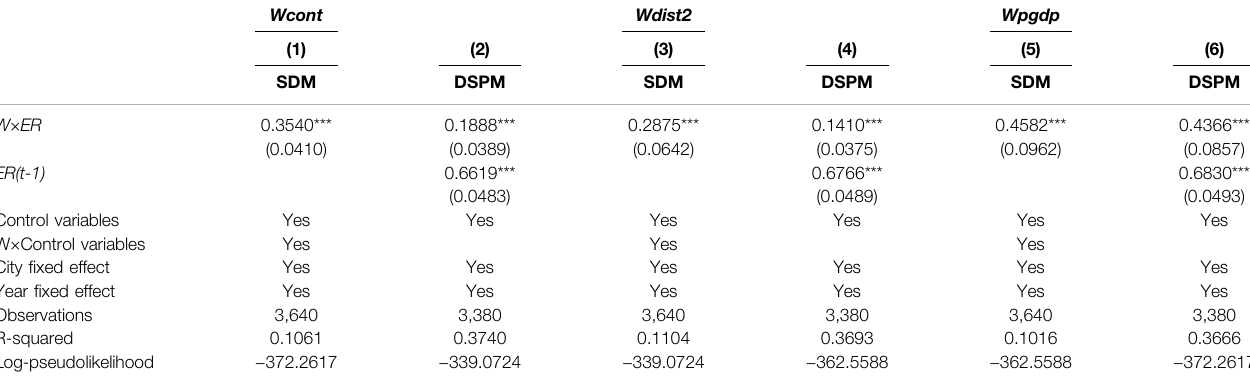
TABLE 7 | Estimates for the spatial Durbin model (SDM) and the dynamic spatial panel data models (DSPM). Wcont